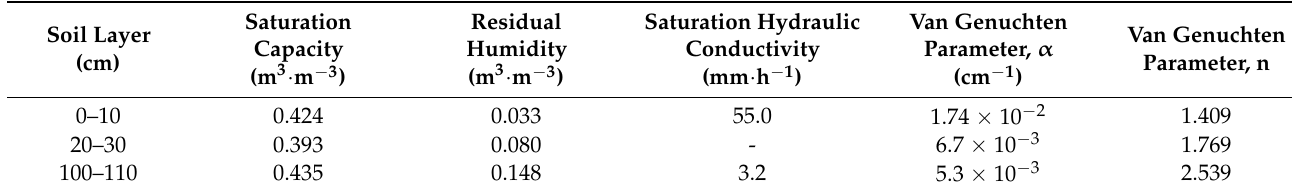
Table 3. The characteristic parameters of different soil layers at Weishan flux